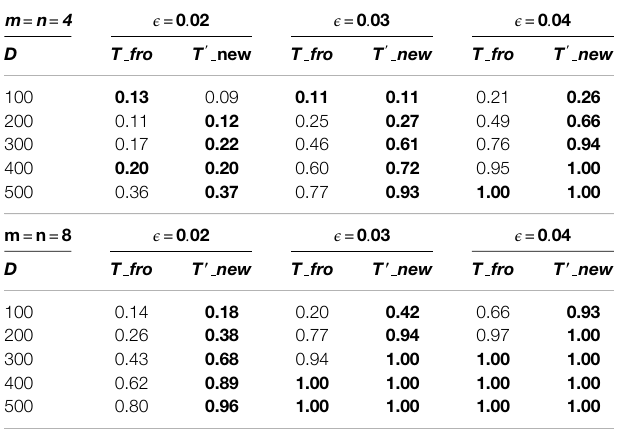
TABLE 2 | Power of the proposed test for directed graphs with varying sparsity levels. m = n = 4